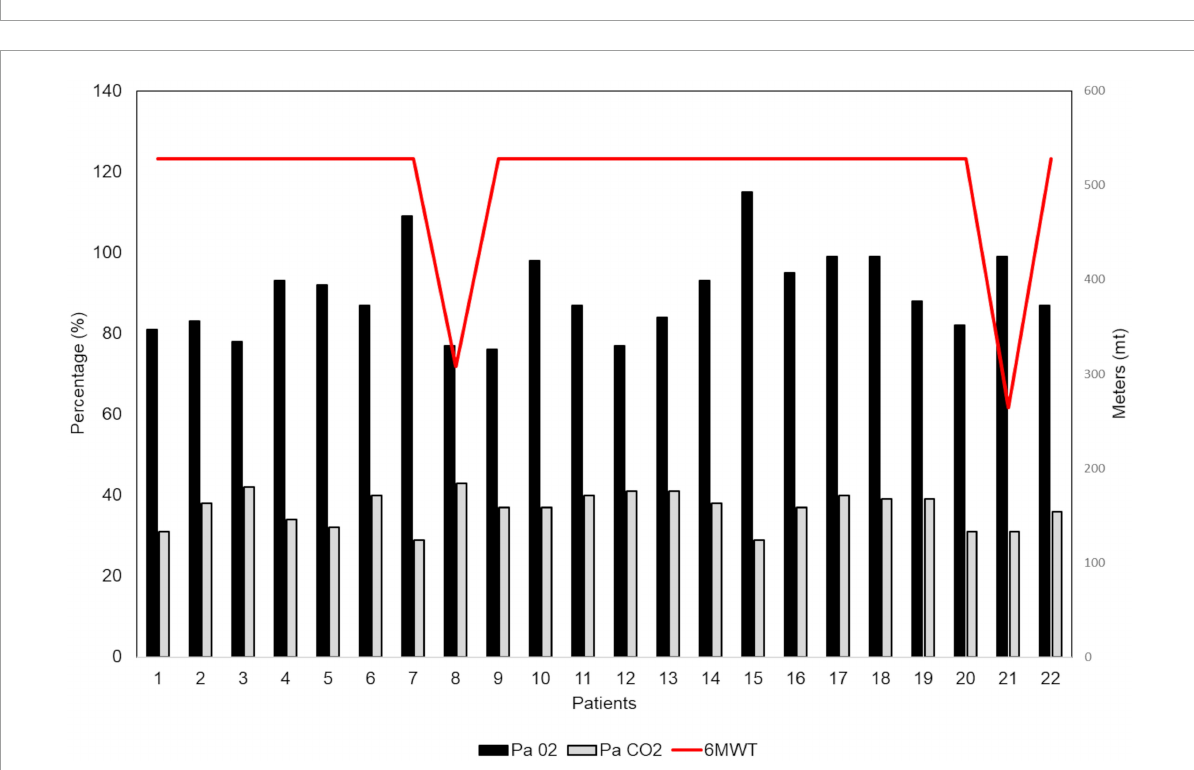
FIGURE3 Six-min walking test (6MWT) in our patients with primary Sjögren’s syndrome (pSS) ( N = 22). At the 6MWT 20 patients (92%) have traveled more than 500 m and 2 patients (9%) have traveled less than 500 m (red line). All patients underwent an arterial blood gas (ABG) analysis for assessing their oxygenation status (PaO 2 = black column; PaCO 2 = gray column) and acid-base